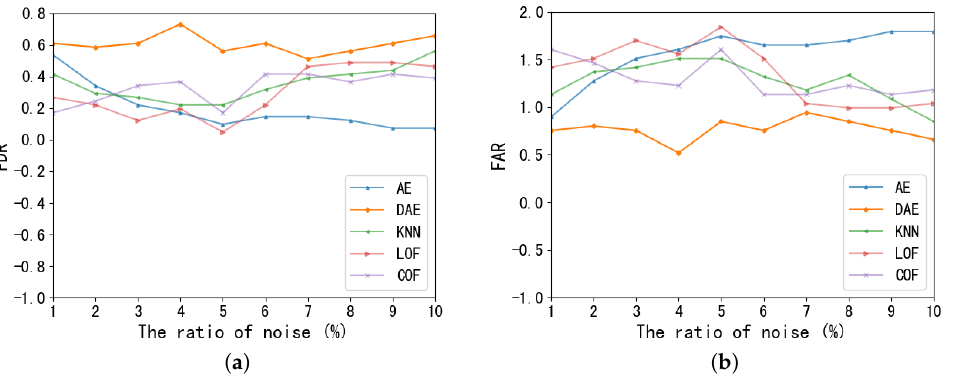
Figure 6. Performance of FDR and FAR for each model with different noise ratios. ( a ) FDR. ( b )